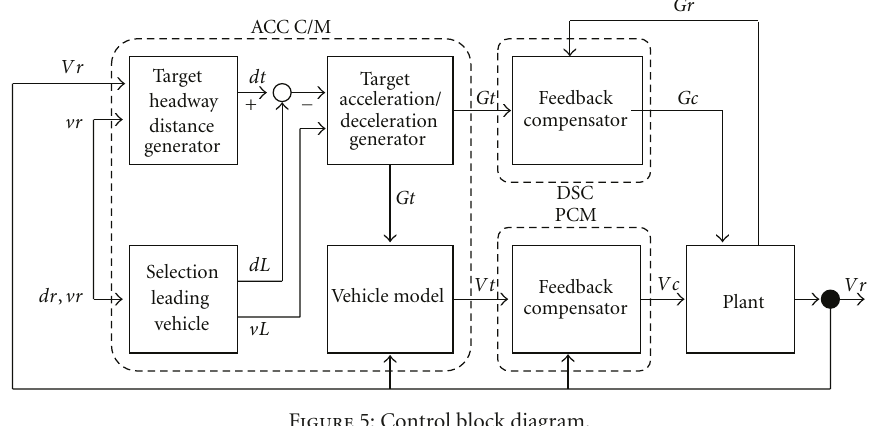
Figure 5: Control block diagram.